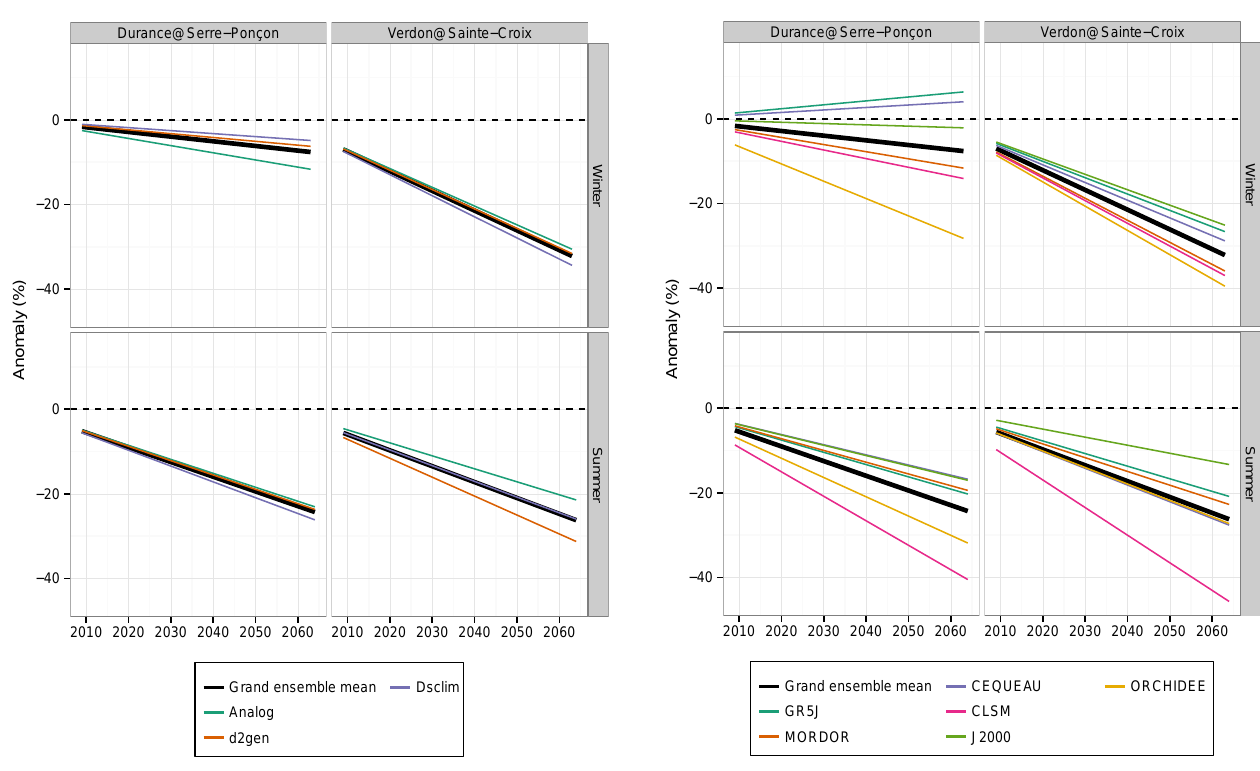
Figure 5. As for Fig. 4, but for SDM effects. Figure 6. As for Fig. 4, but for HM